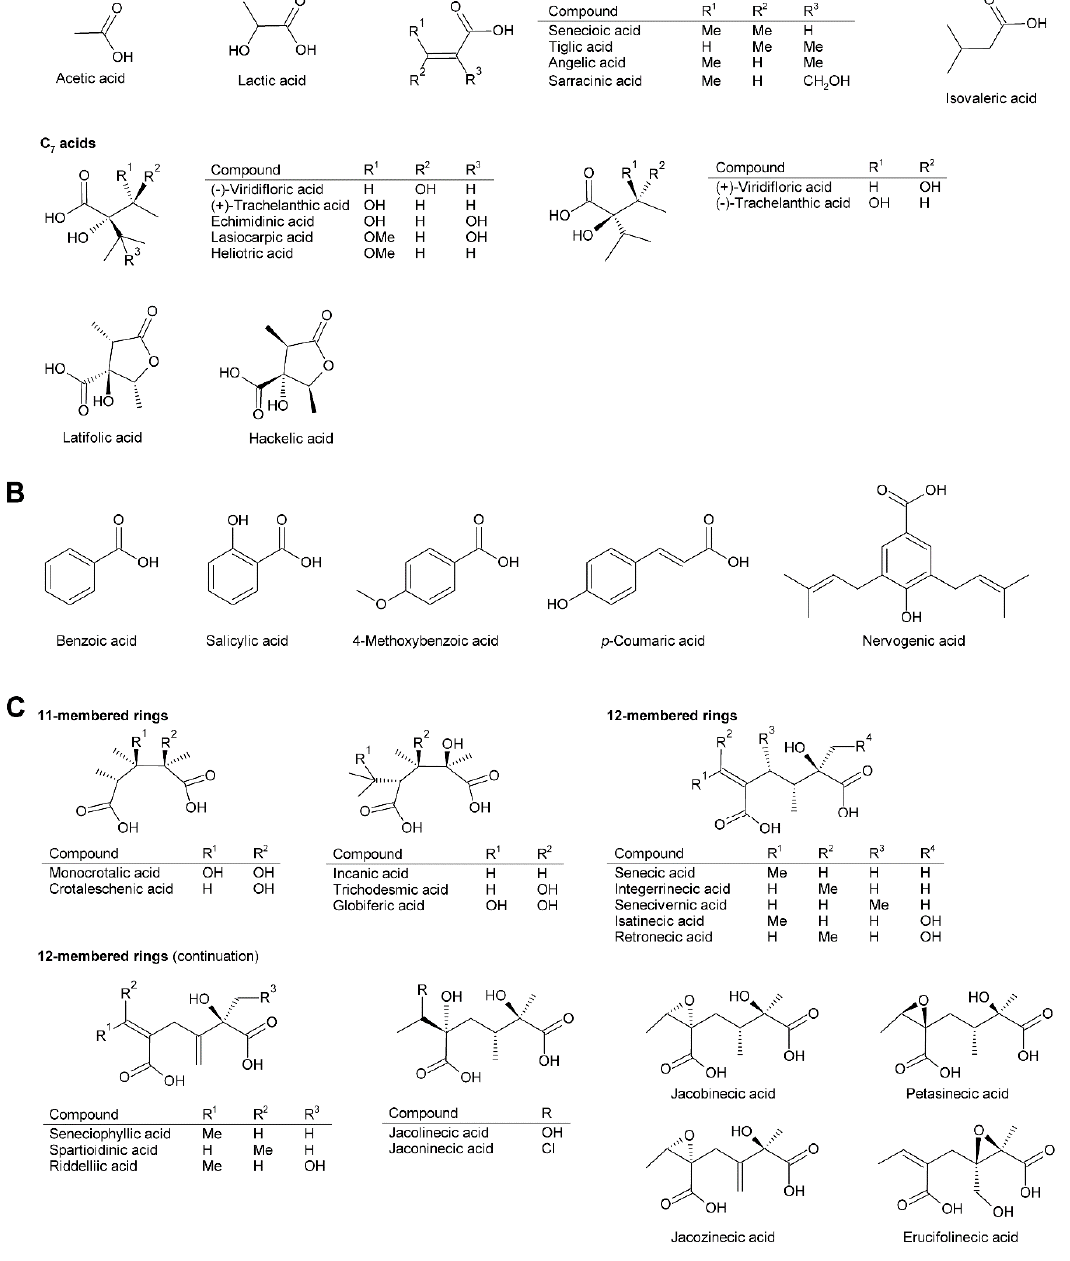
Figure 4. Examples for necic acids. ( A ) Monocarboxylic aliphatic acids. ( B ) Monocarboxylic aromatic acids. ( C ) Dicarboxylic acids forming macrocyclic PAs. Adapted from Reference [17].